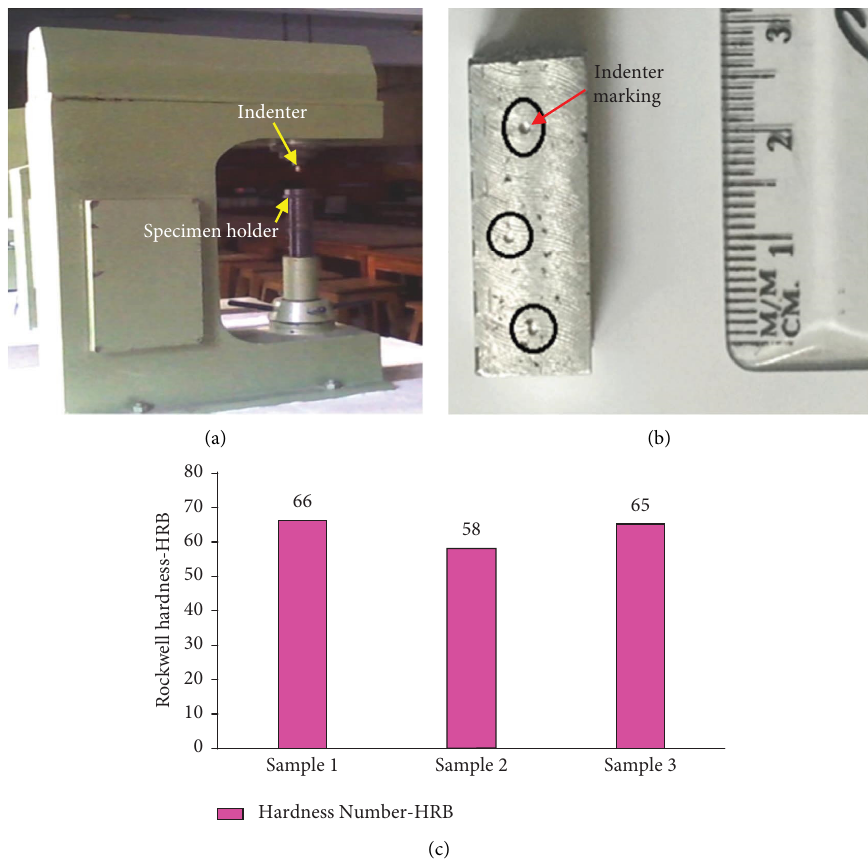
Figure 7: (a) Rockwell hardness tester; (b) hardness specimen; (c) hardness test results.